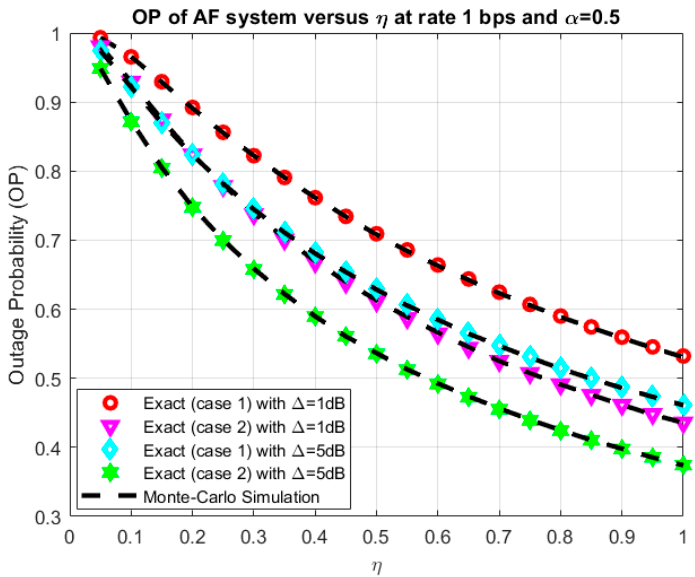
Figure 5. OP versus η .